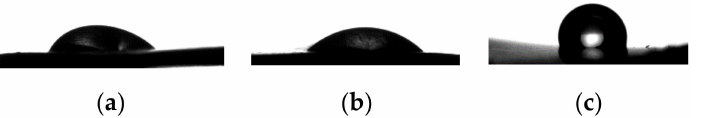
Figure 5. Photographs of the water drops on the surface of the: CS layer only, RT treated ( a ), CS layer only, thermally treated at 100 ◦ C ( b ); 3 layers of the ZrO 2 layer only ( c ).